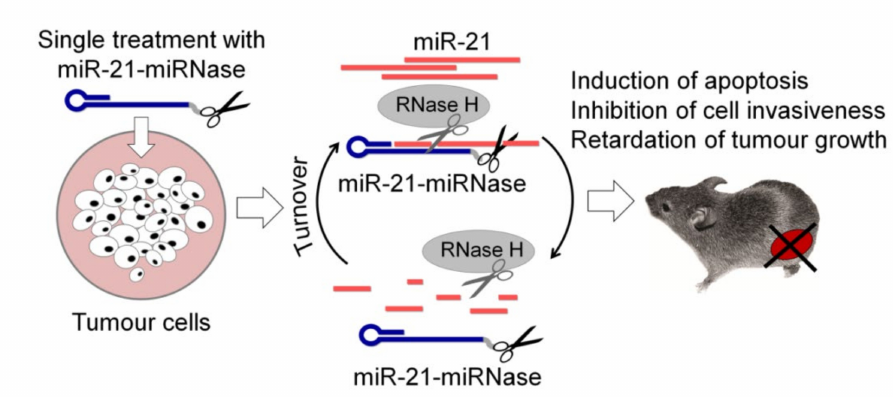
Figure 3. Anti-tumour effect of miR-21-targeted miRNase, achieved due to the synergistic degrada- tion of miRNA-target by jointly miRNase and RNase H in a multi-turnover